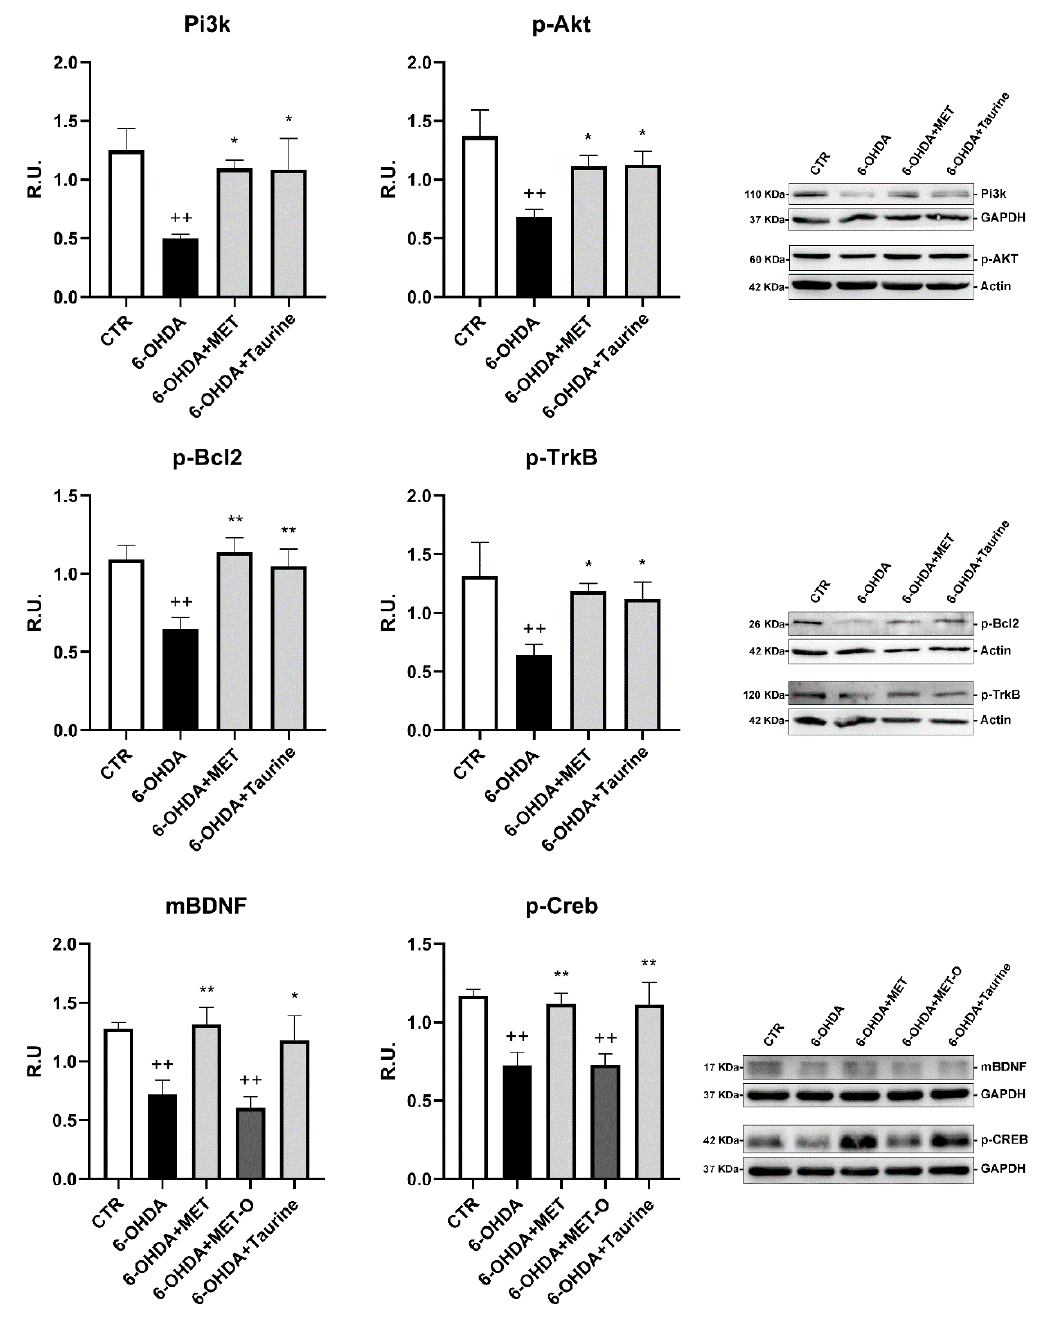
Figure 5. WB analyses for neuroprotective pathways. A representative WB figure is shown. Data are mean ± SD of 3 different experiments. * p < 0.05, ** p < 0.005 vs. 6-OHDA; ++ p < 0.005 vs. CTR.